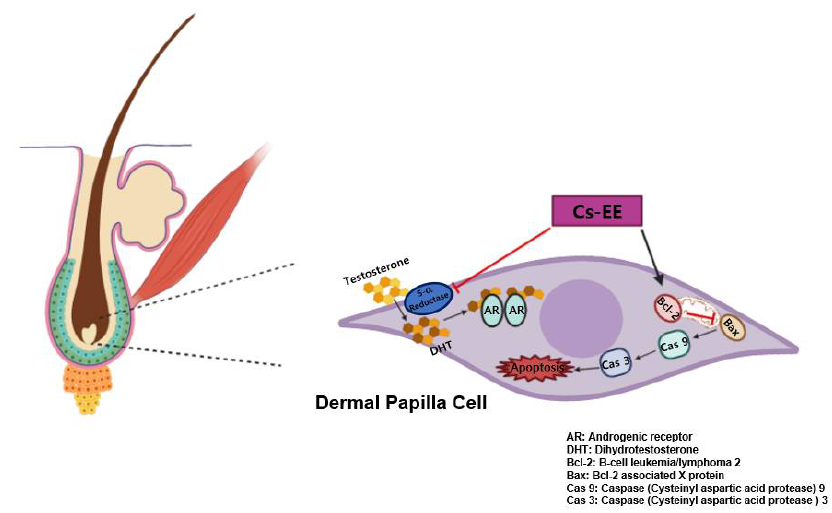
Figure 8. Schematic representation showing the anti-androgenic and anti-apoptotic effects of Cs-EE.